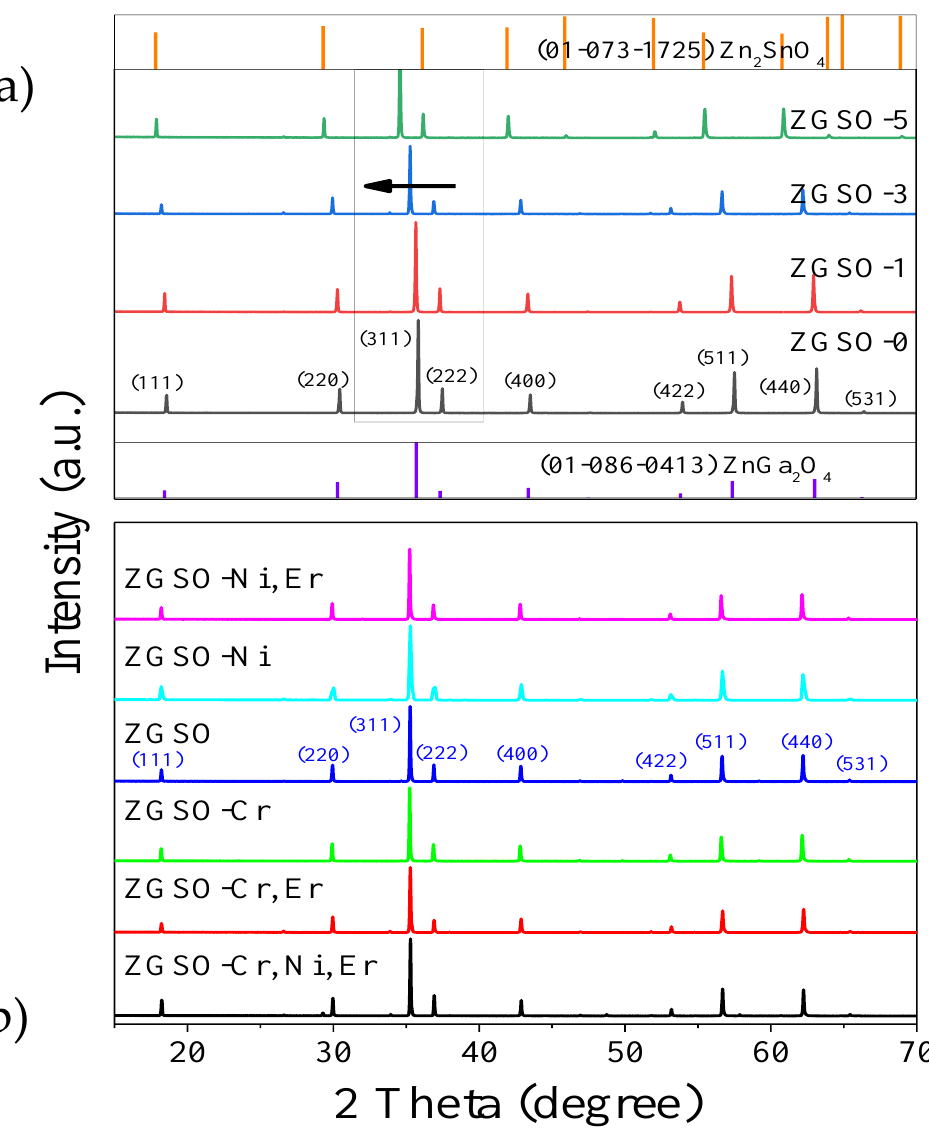
Figure 1. X-ray diffraction spectra of ( a ) ZGSO 0, 0.1, 0.3, and 0.5 concentration ratios of Sn/Ga matched to samples ZGSO-0, ZGSO-1, ZGSO-3, ZGSO-5, respectively. ( b ) Transition-metal (Ni 2+ and/or Cr 3+ ) and rare-earth (Er 3+ ) ion-doped ZGSO-3.